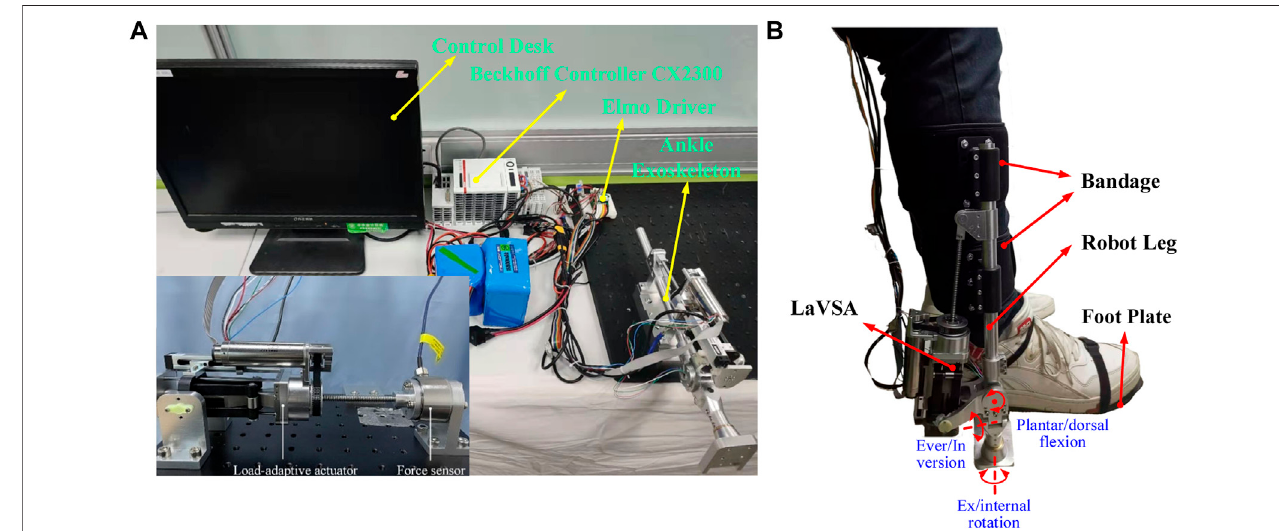
FIGURE 1 | Schematic diagram of the experimental setup. (A) Testing platform. (B) Human – robot interaction scene.